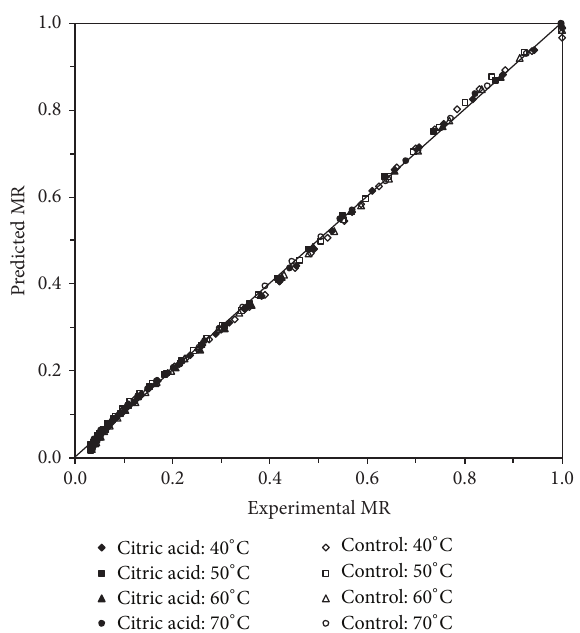
Figure 5: Arrhenius-type relationship between effective moisture diffusivity and reciprocal absolute temperature.